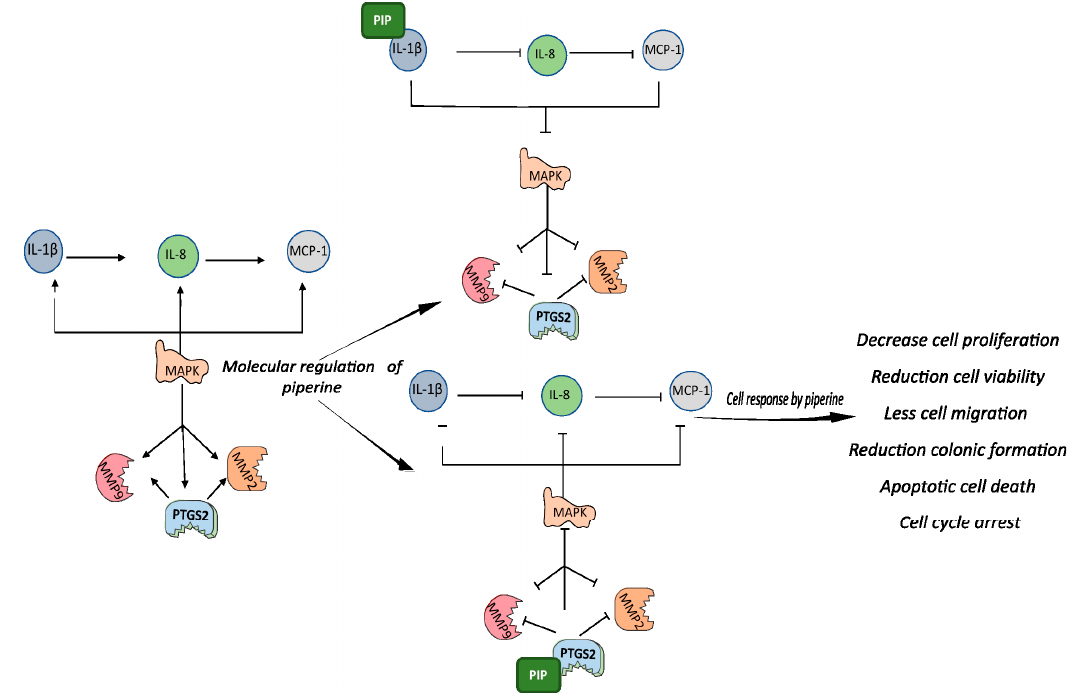
Figure 8. Graphic representation of piperine-mediated modulation of IL-1 β and PTGS. Graphical abstract representation of the relationship between the studied pathways and the results: IL-1 β cytokines induce the expression of IL-8, which in turn stimulates the expression of MCP-1. All these cytokines are regulated by PTGS2, which jointly regulates them via positive feedback, using the MAPK pathway as an intermediary. MMPs are also stimulated by cytokines and PTGS2. When piperine binds to PGS2, all those involved in the pathway are downregulated, and the same occurs when piperine binds to IL-1 β . The molecular responses to piperine modulation result in reduced viability, proliferation, migration, and colony formation in addition to activation of apoptosis, DNA fragmentation, and cell arrest in the cell